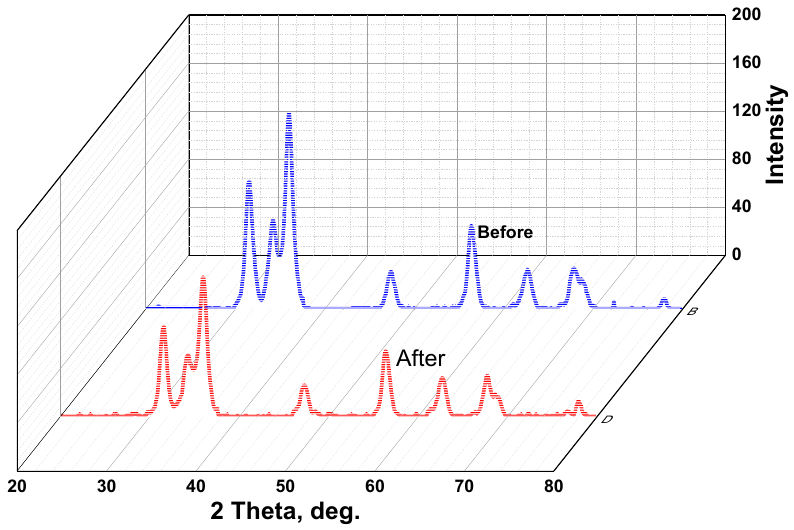
Figure 14. XRD patterns of catalyst [ZnO:Ag (10%) ] before (Cycle 1) and after (Cycle 5) stability tests.